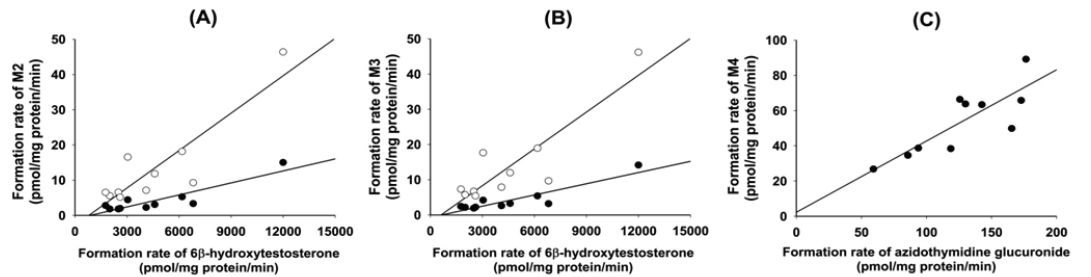
Figure 4. Correlation between the formation rates of ( A ) 4( S )-hydroxyevogliptin (M2) and ( B ) 4( R )-hydroxyevogliptin (M3) from 10 μ M (  ) and 50 μ M (  ) evogliptin and testosterone 6 β -hydroxylase activity in 10 different human liver microsomes; ( C ) Correlation of the formation rates of 4( S )-hydroxyevogliptin glucuronide (M4) from 100 μ M 4( S )-hydroxyevogliptin to azidothymidine glucuronidation activity in 10 different human liver microsomes.